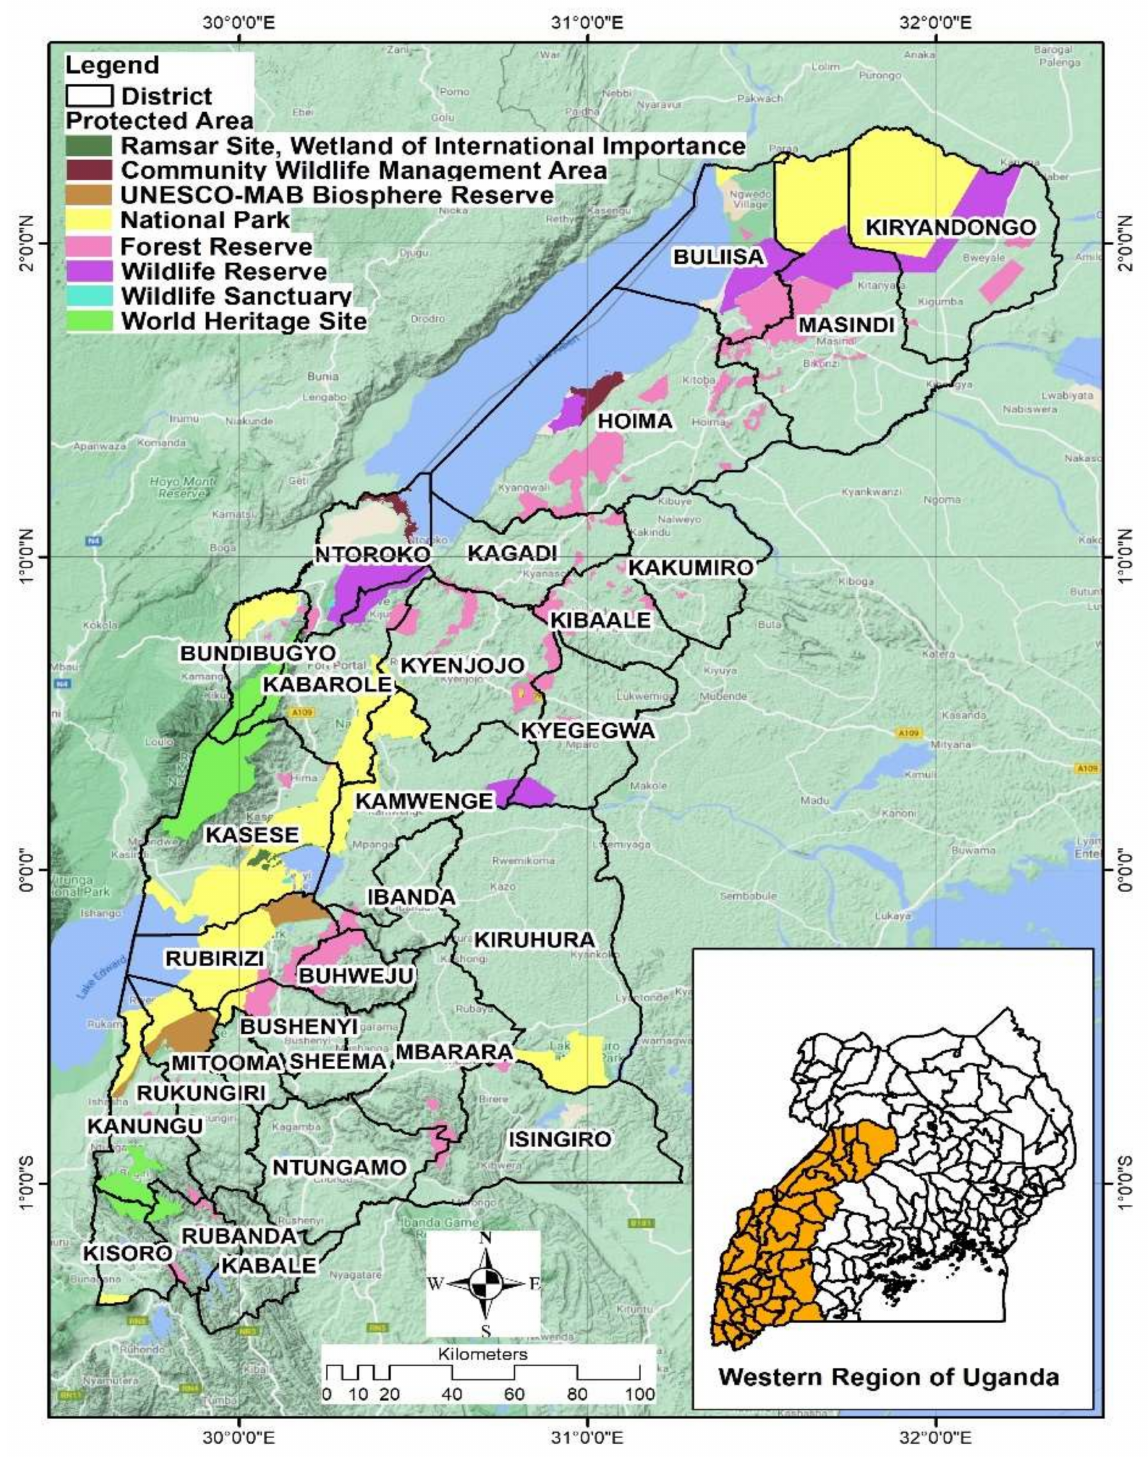
Figure 6. Map of protected areas in the study